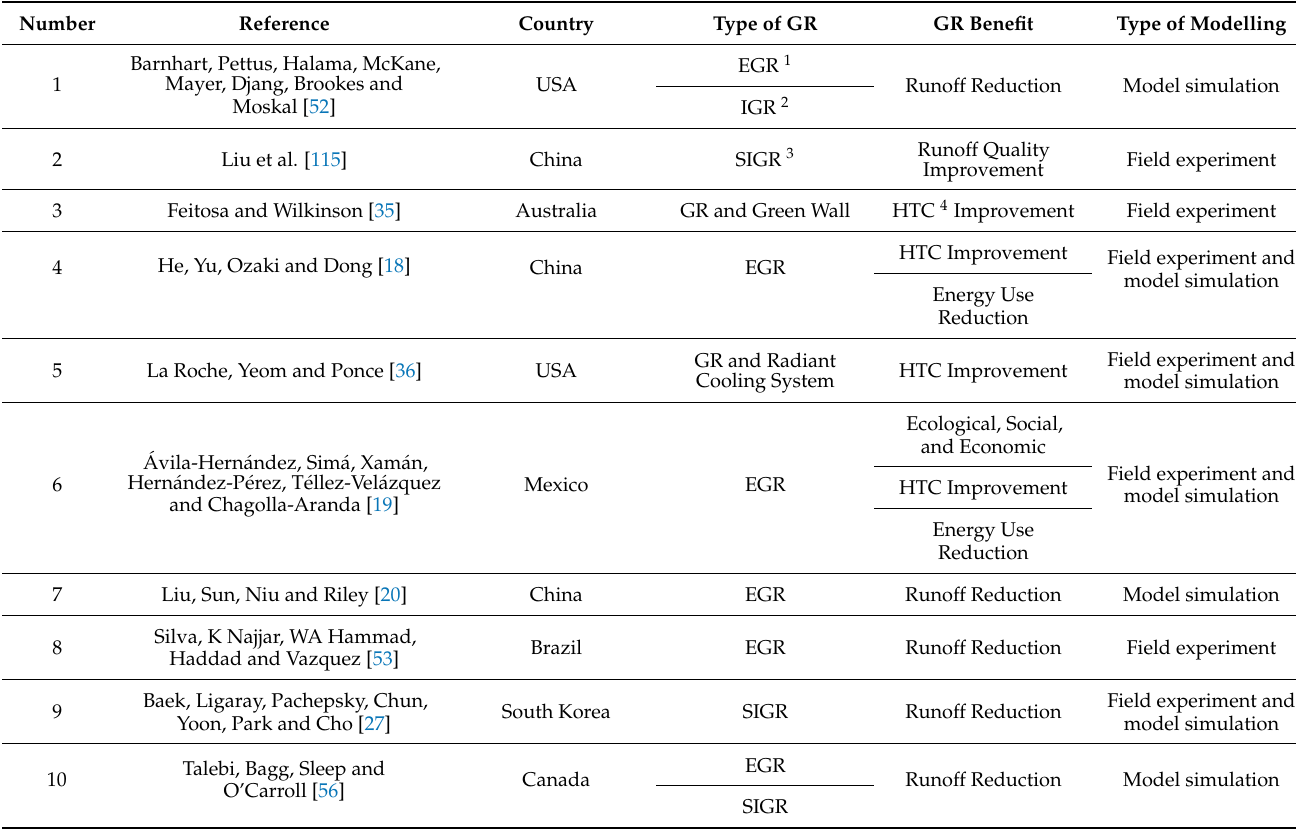
Table A1. An overview of green roof papers reviewed in this